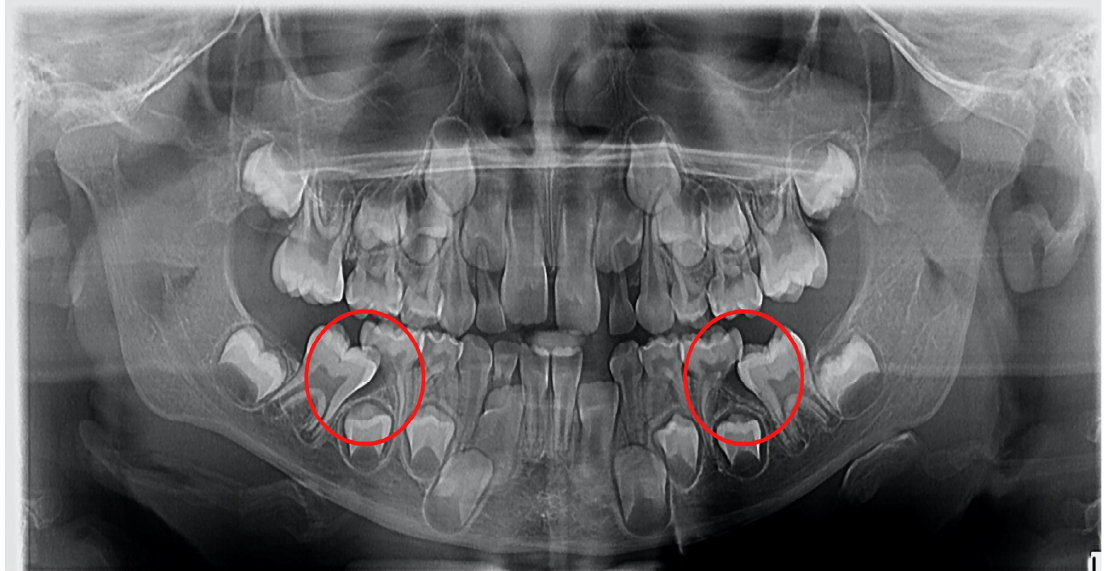
Figure 2. Ectopic eruption of lower first permanent molars.